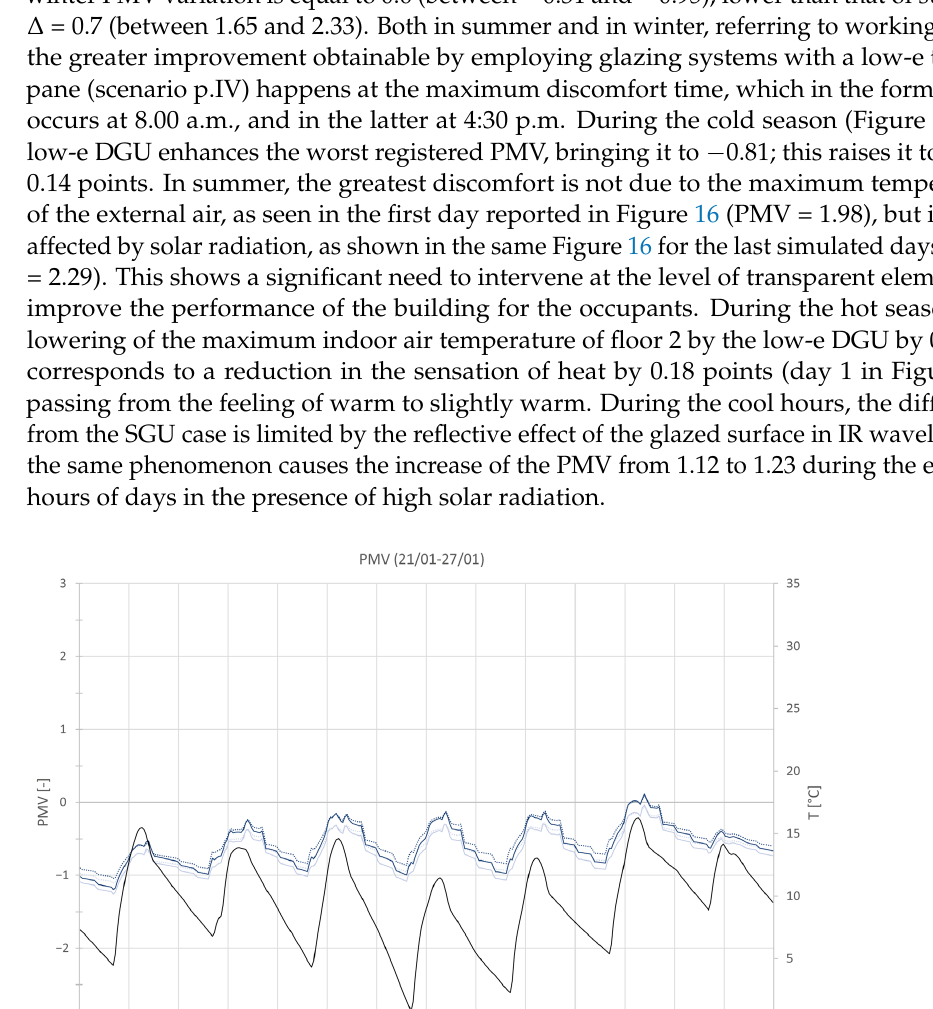
Figure 16. Comparison between PMV in current and low-e configuration during a typical summer week (floor 2). During a typical day in the summer (Figure 17), the PPD with a SGU varies from 82% to 20%, corresponding to a PMV of 2.14, warm, and 0.83, light warm, respectively; the lower peaks are only qualitatively indicative, since the occupation period does not include the time period from 8.00 p.m.to 8.00 a.m. The abovementioned values refer to the trend of the fourth floor, which undergo the greatest oscillation due to the greater area of exter- nal dispersant surfaces compared to the other floors. PPD fluctuation is reduced as you move to the lower floors: at the first floor, the minimum PPD of 32% has a significant ground contribution. In the mid-season period (May), PPD during working hours is